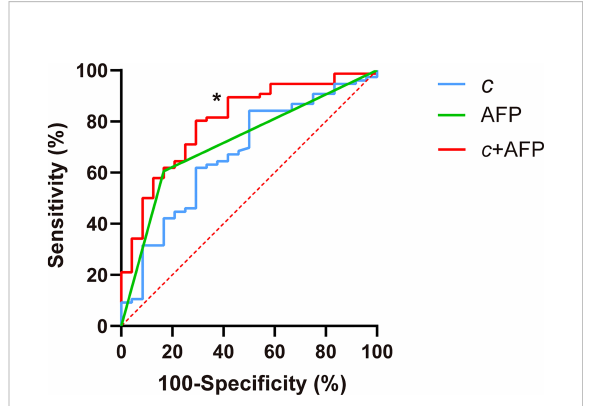
FIGURE 5 Receiver operating characteristic curves for assessing the diagnostic performance in identifying GPC3-positive HCC using c (stiffness), AFP, and both markers combined ( c + APF). Area-under-the-curve (AUC) values using different biomarkers were compared with respect to that of c using the Delong test for c. * P <